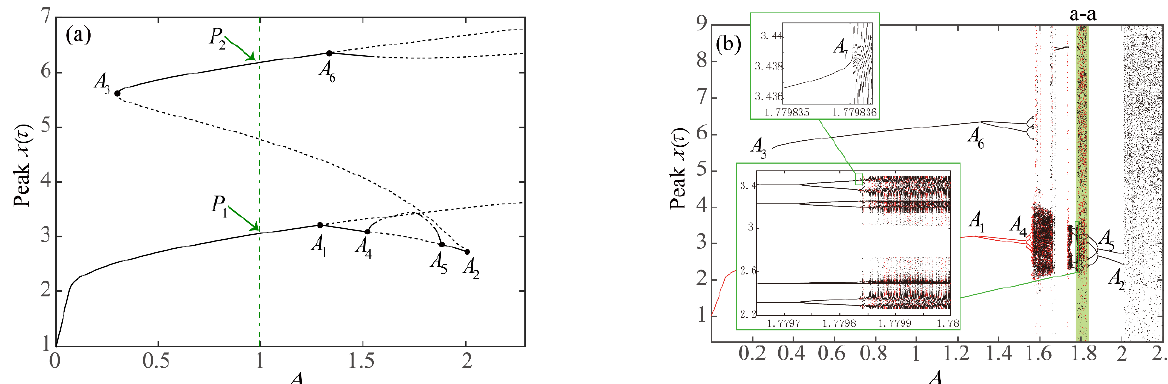
Figure 8. One-sided contact system for ω = 1, ( a ) the periodic solution branch as the excitation amplitude A varies, and ( b ) numerical bifurcation diagrams of x ( τ ) when A sweeps up (black dots) and down (red dots).